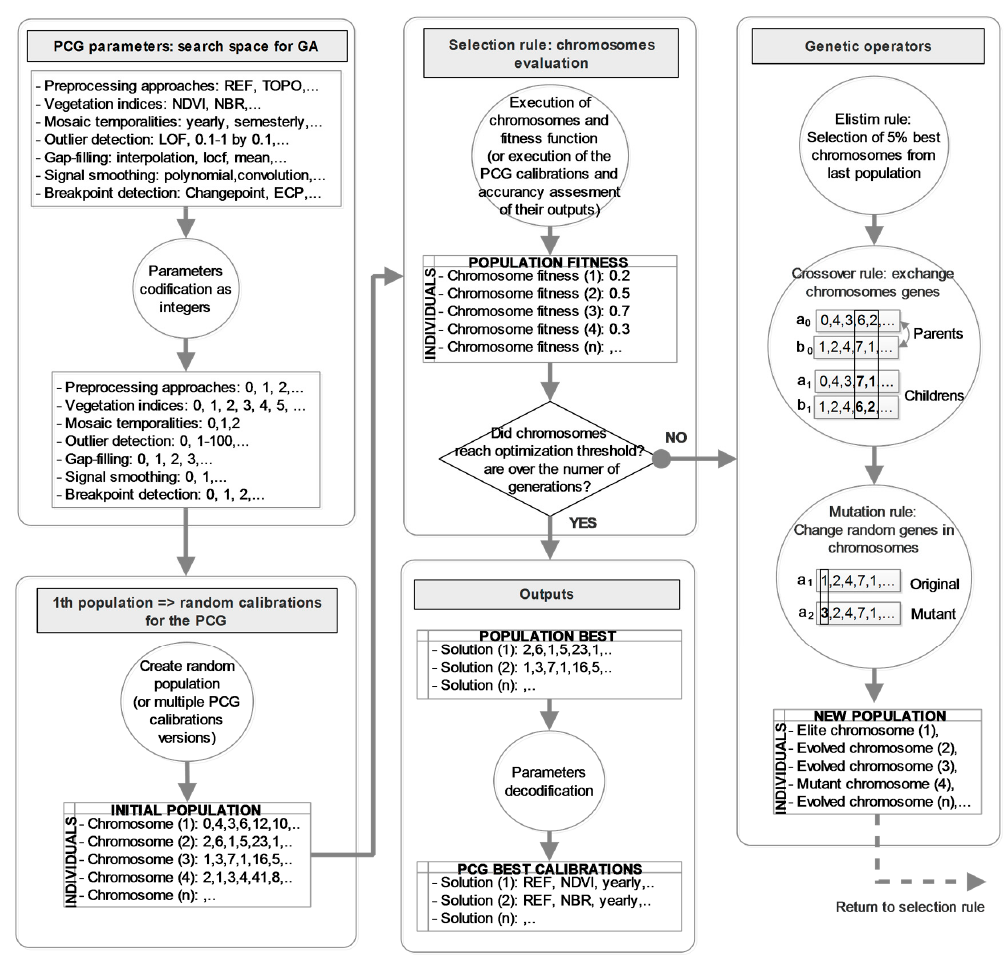
Figure 7. GA applied to PCG workflow.